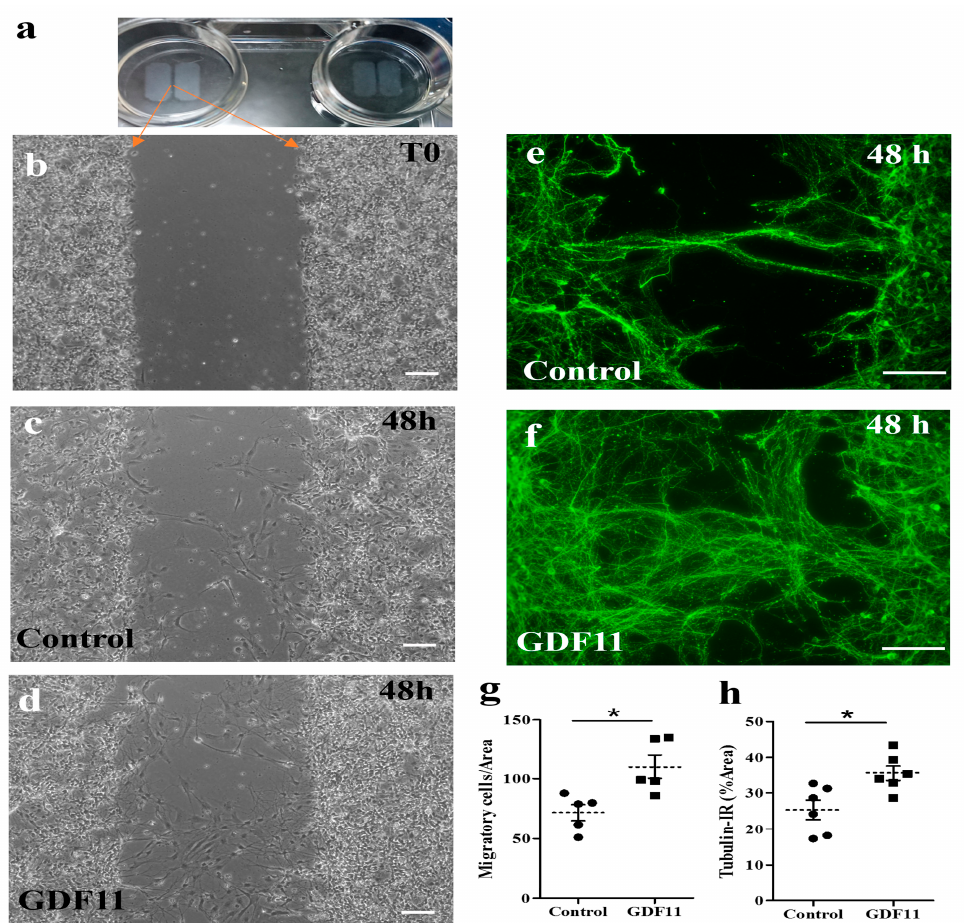
Figure 2. Effect of GDF11 on neuronal or oligodendroglial survivals in neuron–glial cultures. ( a , c ) Control cells; ( b , d ) GDF11-treated cells. Cells in ( a , b ) are β III tubulin-immunoreactive (IR) neuronal cells. Cells in ( c , d ) are Rip-IR oligodendroglial cells. ( e ) Quantification of β III tubulin-IR cell density in cultures of ( a , b ) per 0.00356 cm 2 . ( f ) Quantification of RIP-IR cell numbers in cultures of ( c , d ) per 0.00356 cm 2 . The results are reported as mean ± SEM in each group. * p < 0.05, ** p < 0.01 Control versus GDF11 treatment by unpaired Student t -test. Magnification: 200×. Scale bar: 100 μ m.